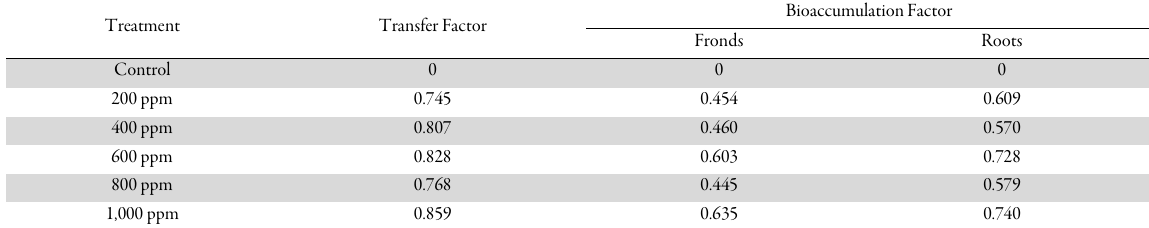
Table 4. Lead bioaccumulation and transfer factor in Pityrogramma calomelanos after growing for 12 weeks in lead contaminated soils